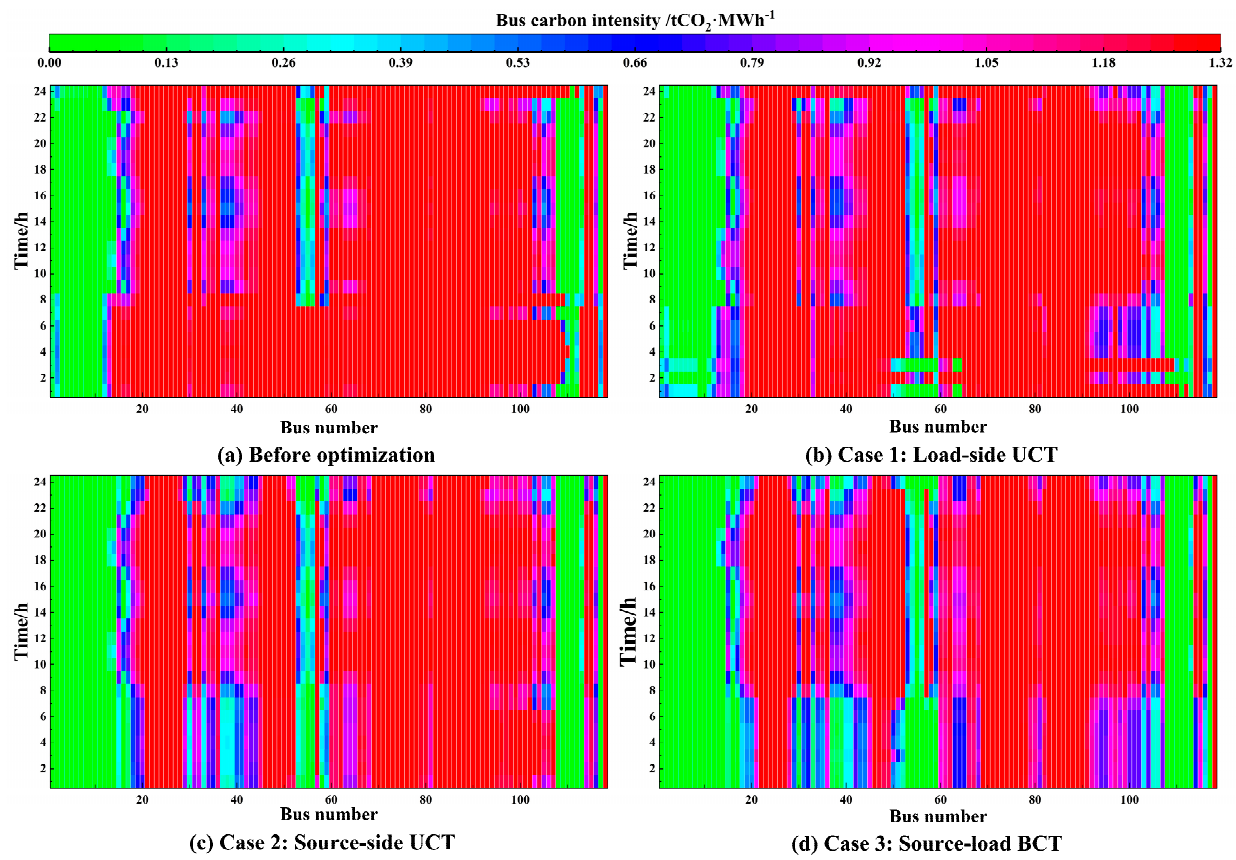
Figure 13. Bus carbon intensities in the three cases and before optimization of the IEEE 118-bus system.